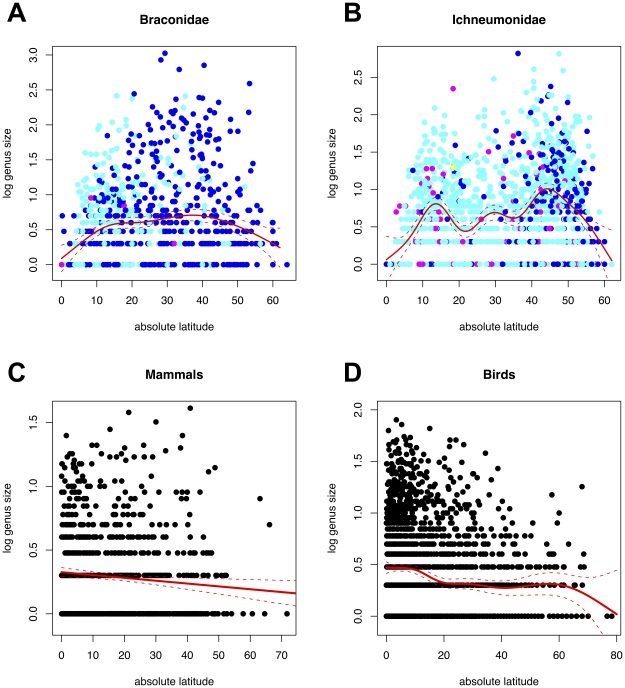
Relationships between numbers of species per genus and median absolute latitude of genera.Plots of log10 numbers of species per genus for all genera of: (A) Hymenoptera, Braconidae; (B) Hymenoptera, Ichneumonidae; (C) mammals; (D) birds. All plots show as a red solid line a GAM fit to the data, +/− (red dashed lines) standard errors. Figures 1 and 2 have genus data points colour coded for wasp body size (dark blue <6.5 mm, cyan = 6.6–19.5 mm, magenta = 19.6–33 mm, yellow = >33.1 mm).